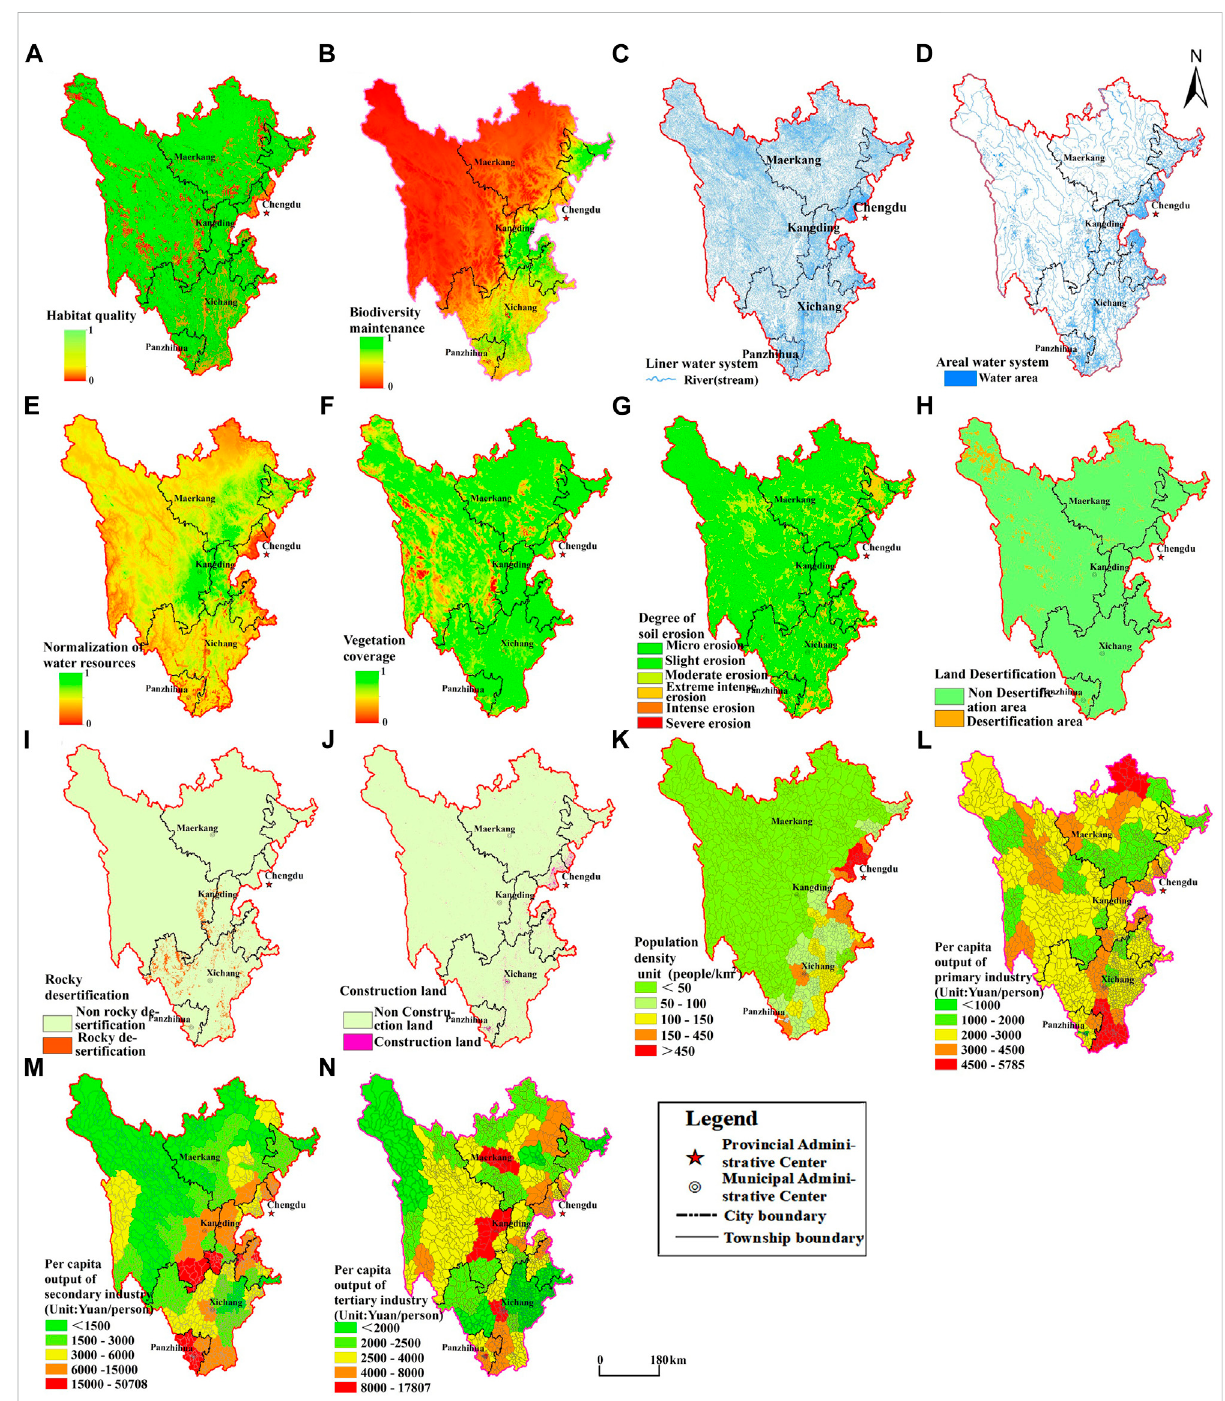
FIGURE 4 Spatial variation of source data corresponding to sub-indicators in 2009. (A) Habitat quality, (B) Biodiversity maintenance function, (C) Line water system, (D) Areal water system, (E) Normalization of water resources, (F) Vegetation coverage, (G) Degree of soil erosion, (H)